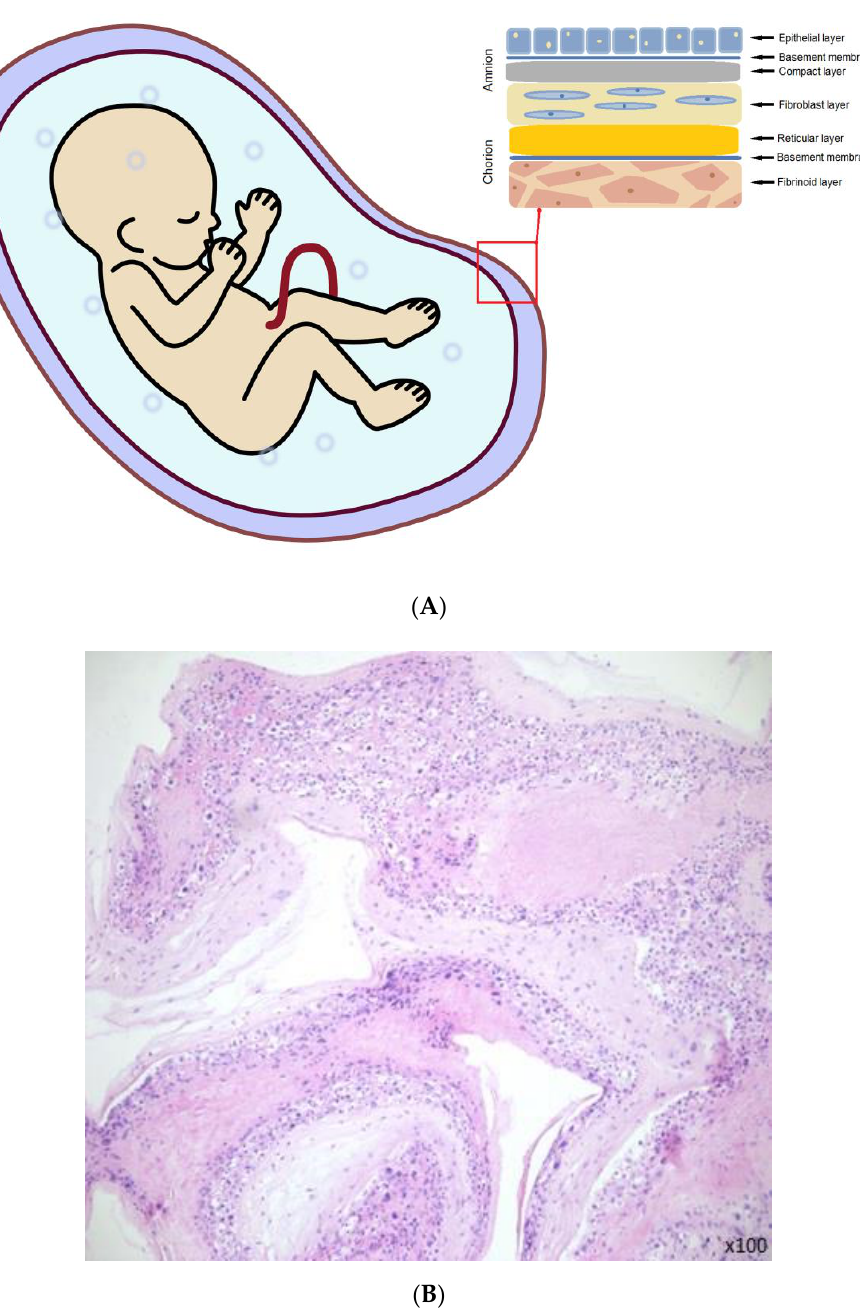
Figure 1. ( A ) The amniotic membrane layers [6]. ( B ) Section of fresh amniotic membrane with epithelial cells.